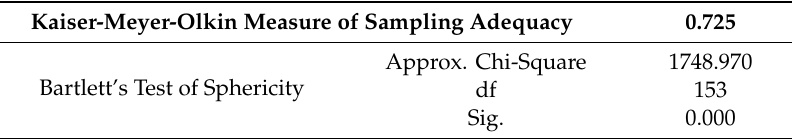
Table 6. Sampling adequacy for the factor